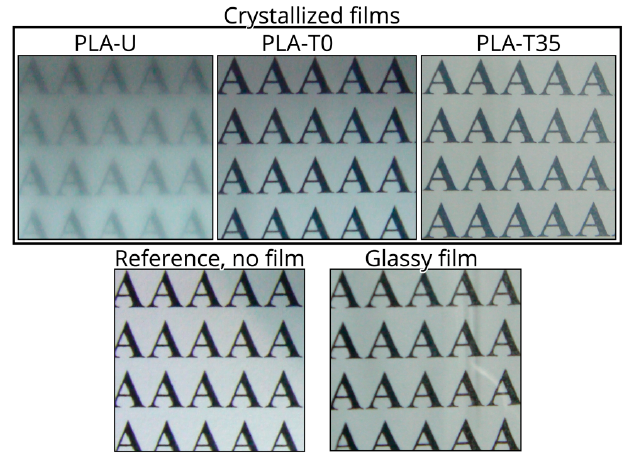
Figure 9. See-through (on the top on a text page) macrographs of PLA films of 20 μ m thickness, fully crystallized at 110 °C. For comparison, the pictures of reference with no film and glassy one are also shown in lower row.